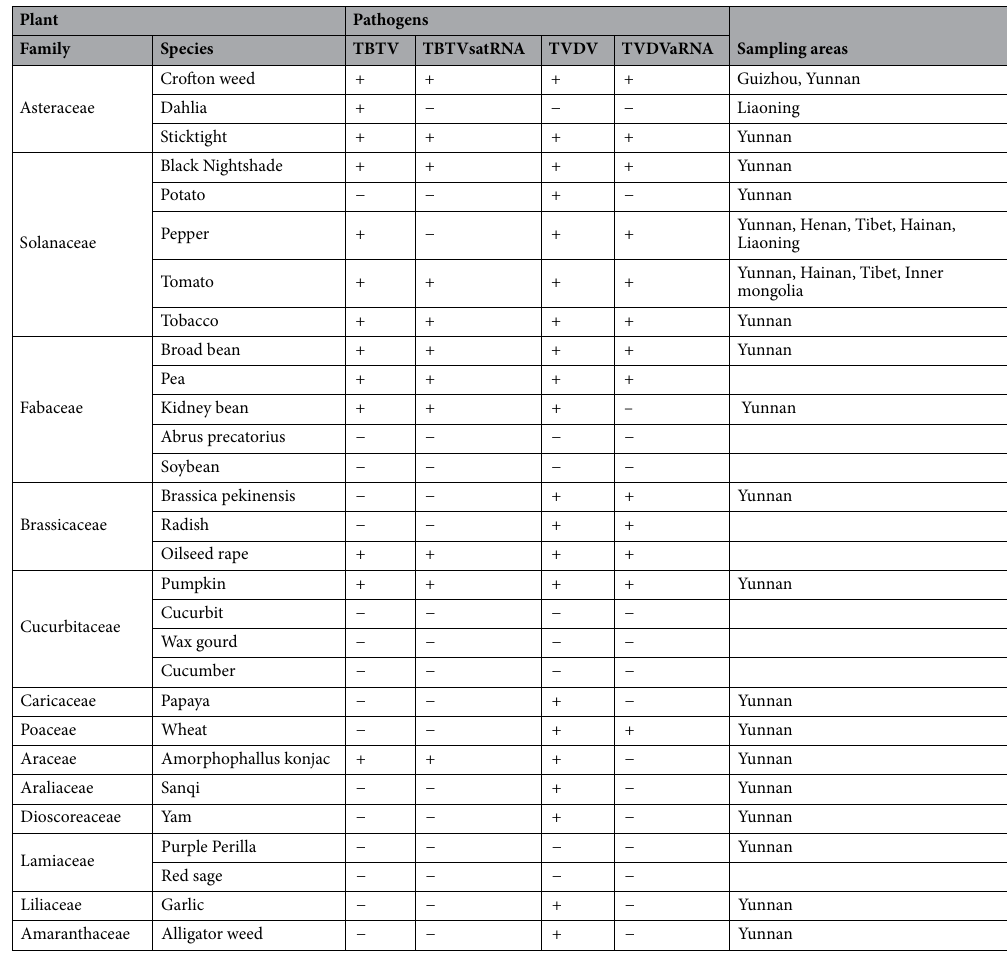
Table 8. Detection of the four TBTD causal viruses in 29 species of plants collected from 11 different provinces or autonomous regions in China. + Positive detection, − negative detection.